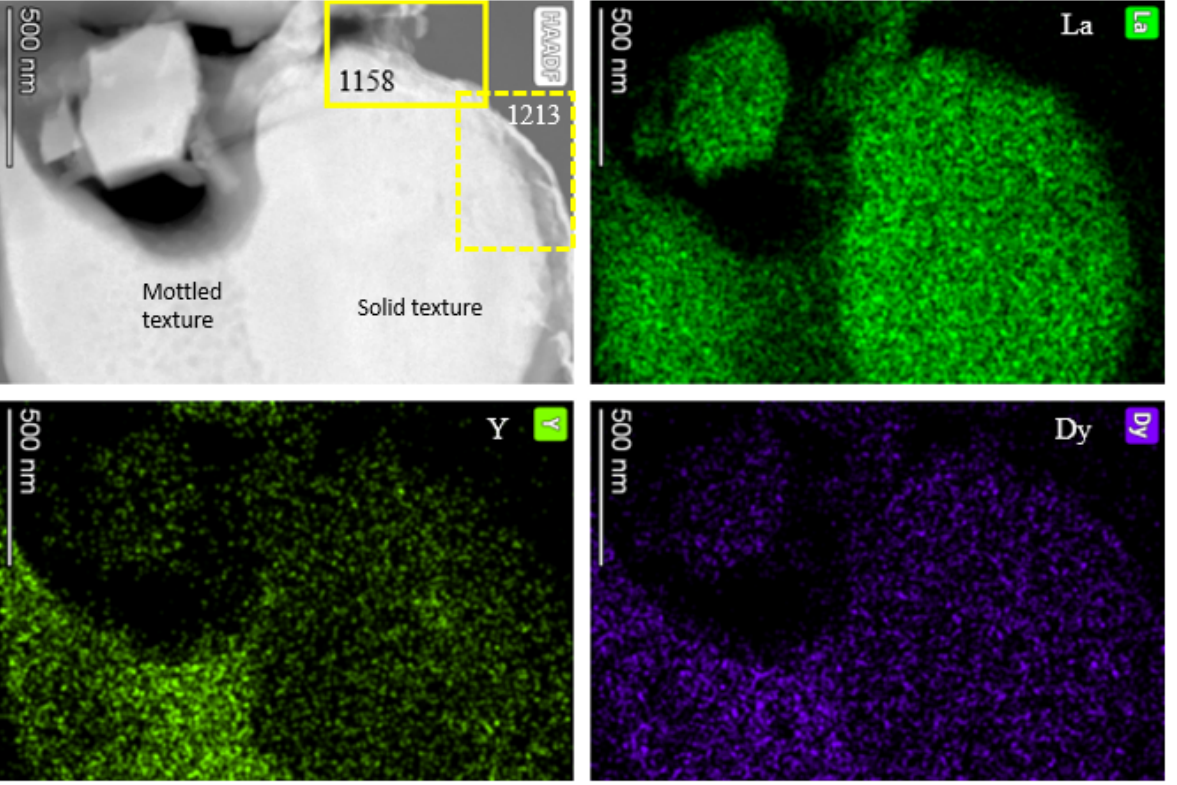
Figure 12. Area 0940. Clockwise from upper left: HAADF image of area with insets of areas 1213 (Figure 10) and 1158 (Figure 16); La element map; Dy element map; and Y element map.